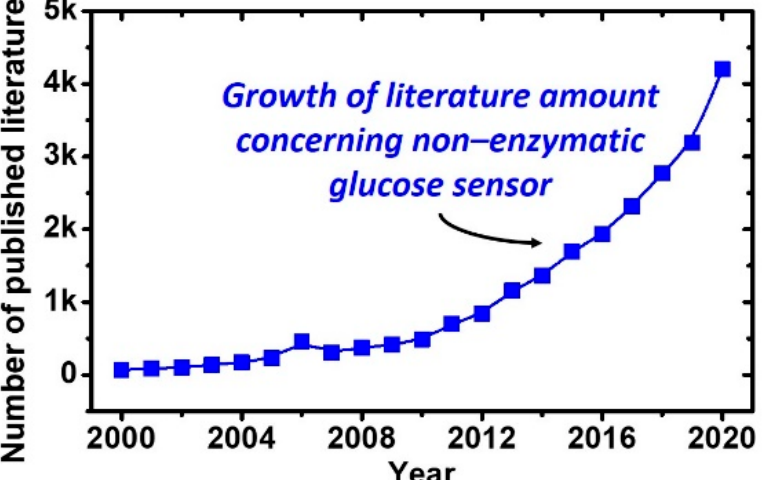
Figure 1. The number of literature concerning the non-enzymatic glucose sensors since 2000. (Data resource from Google Scholar).